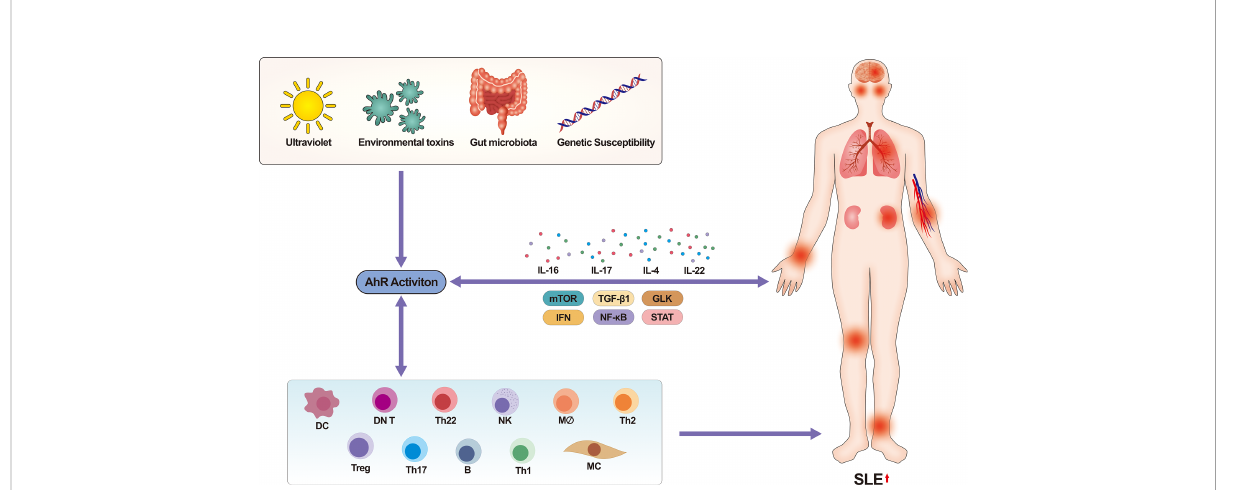
FIGURE 5 Activation of AhR by multiple factors promotes the occurrence and development of human SLE. On the one hand, factors such as ultraviolet, environmental toxins, and gut microbiota will mostly affect the binding of AhR to ligands. AhR regulates the pathophysiological functions of multiple immune cells in a ligand-speci fi c manner, which in turn affects SLE. Meanwhile, many signaling pathways that regulate disease (e.g., mTOR, PD-1, NF- k B, STAT, TGF- b 1, GLK signaling pathway, etc.) also involve activation of AhR, which promotes the development of SLE with the involvement of multiple cytokines. On the other hand, immune cells also secrete various pro-in fl ammatory substances and cytokines that in fl uence the activation of certain signaling pathways. In conclusion, multiple pathways together contribute to the development of SLE through AhR. mTOR, mechanistic target of rapamycin, IFN, interferon, STAT, signal transducer and activator of transcription, TGF, transforming growth factor, GLK, germinal center kinase-like kinase, SLE, systemic lupus